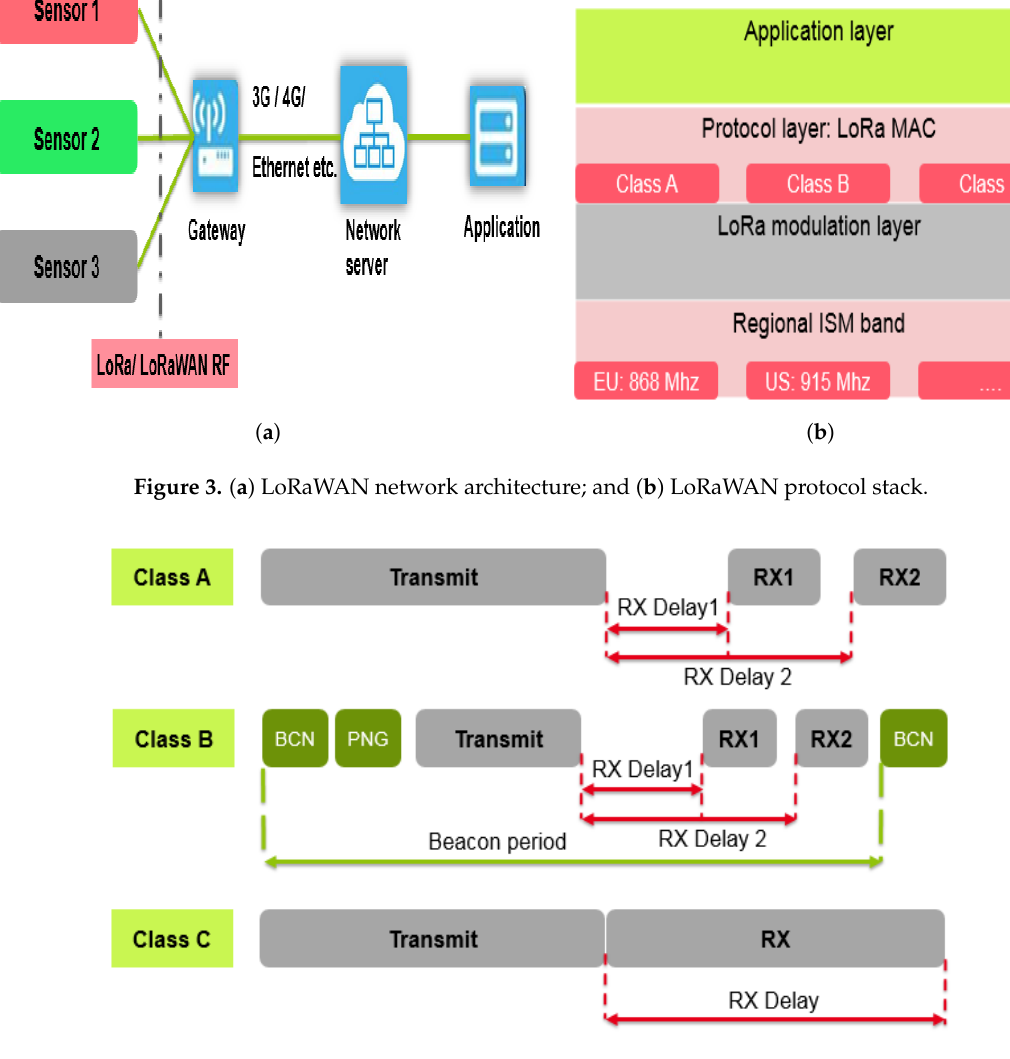
Figure 4. Different LoRaWAN